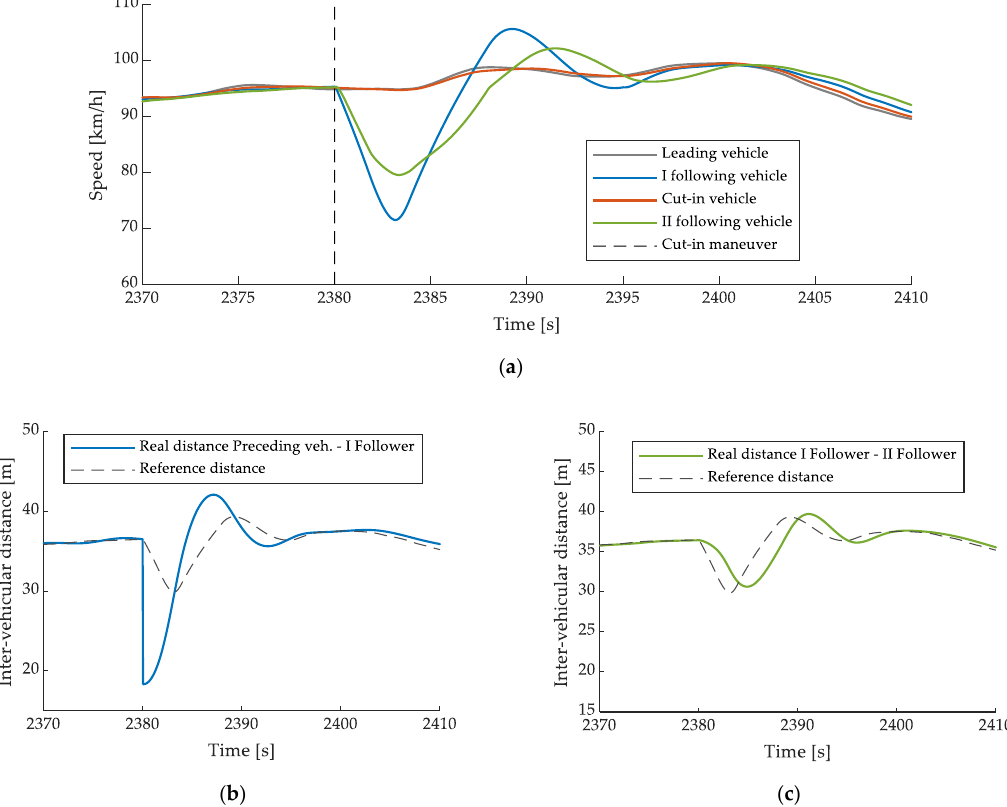
Figure A3. Safety analyses on a coasting phase of the Random Cycle: ( a ) speed traces of the four vehicles (i.e., the three vehicles platooning and the fourth cutting in vehicle (in red)), ( b ) actual and reference inter-vehicular distances between the I follower and its preceding vehicle (i.e., the leader until the cut-in maneuver occurs and then the cut-in vehicle), and ( c ) actual and reference inter-vehicular distances between II and I followers.